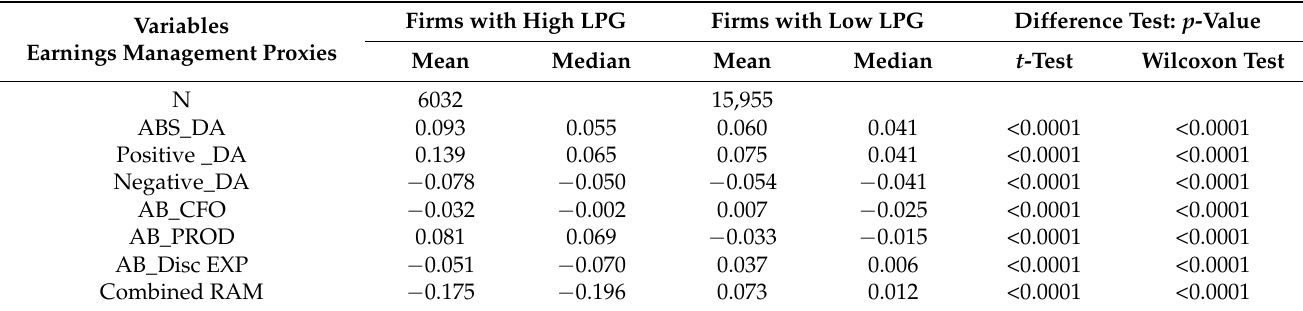
Table 2. Earnings management activities of firms: high LPG vs. low